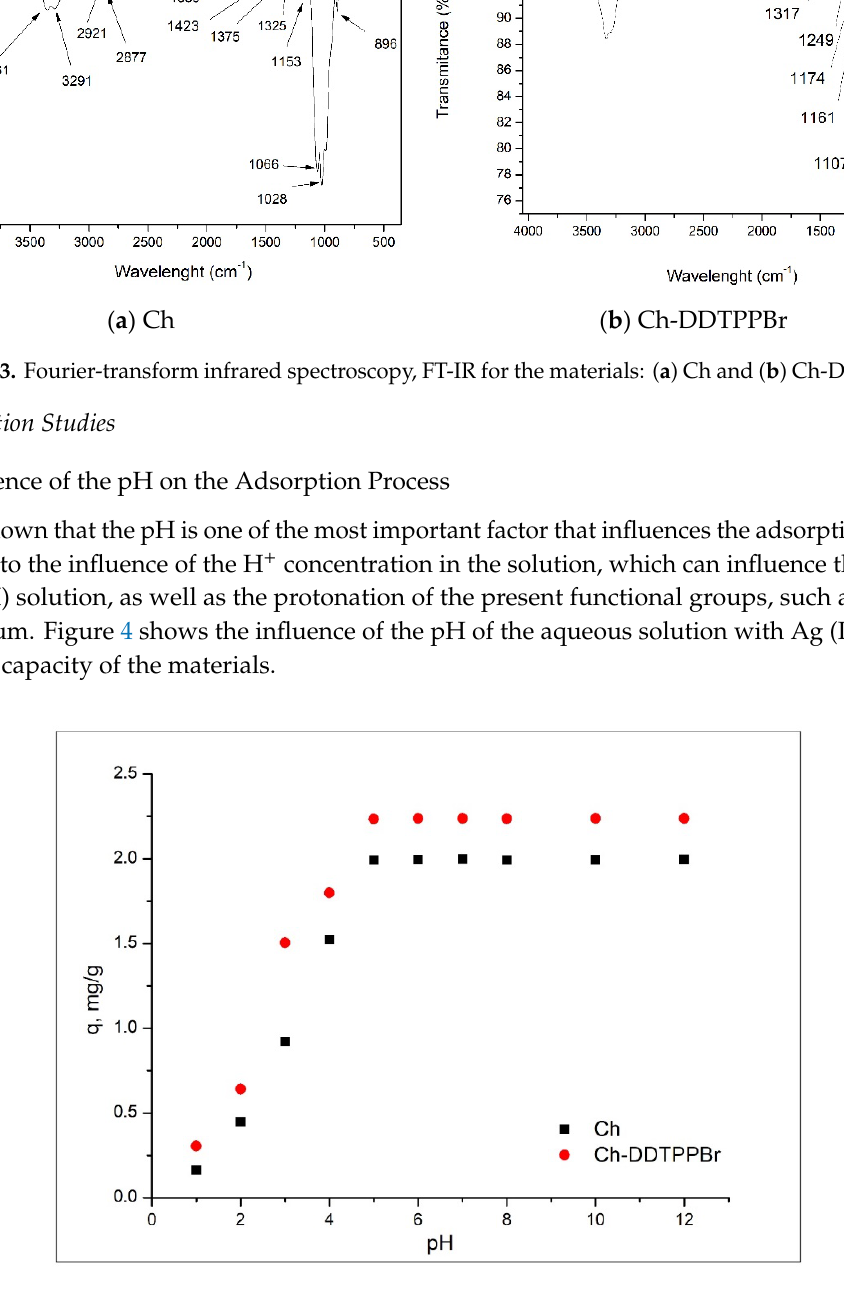
Figure 4. The influence of pH on the adsorption process.